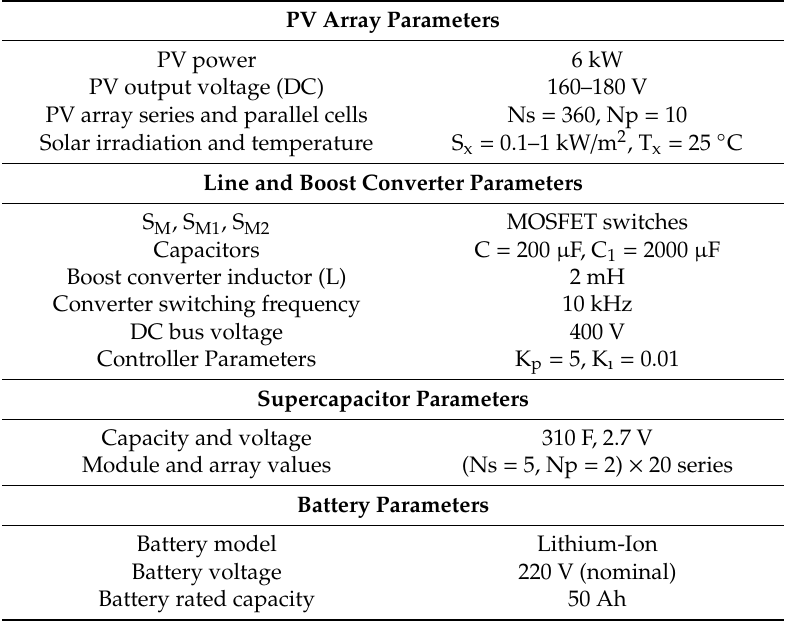
Figure 9. The new topology with HESS in MATLAB / Simulink. Table 5. Simulation parameters of HESS MATLAB / Simulink